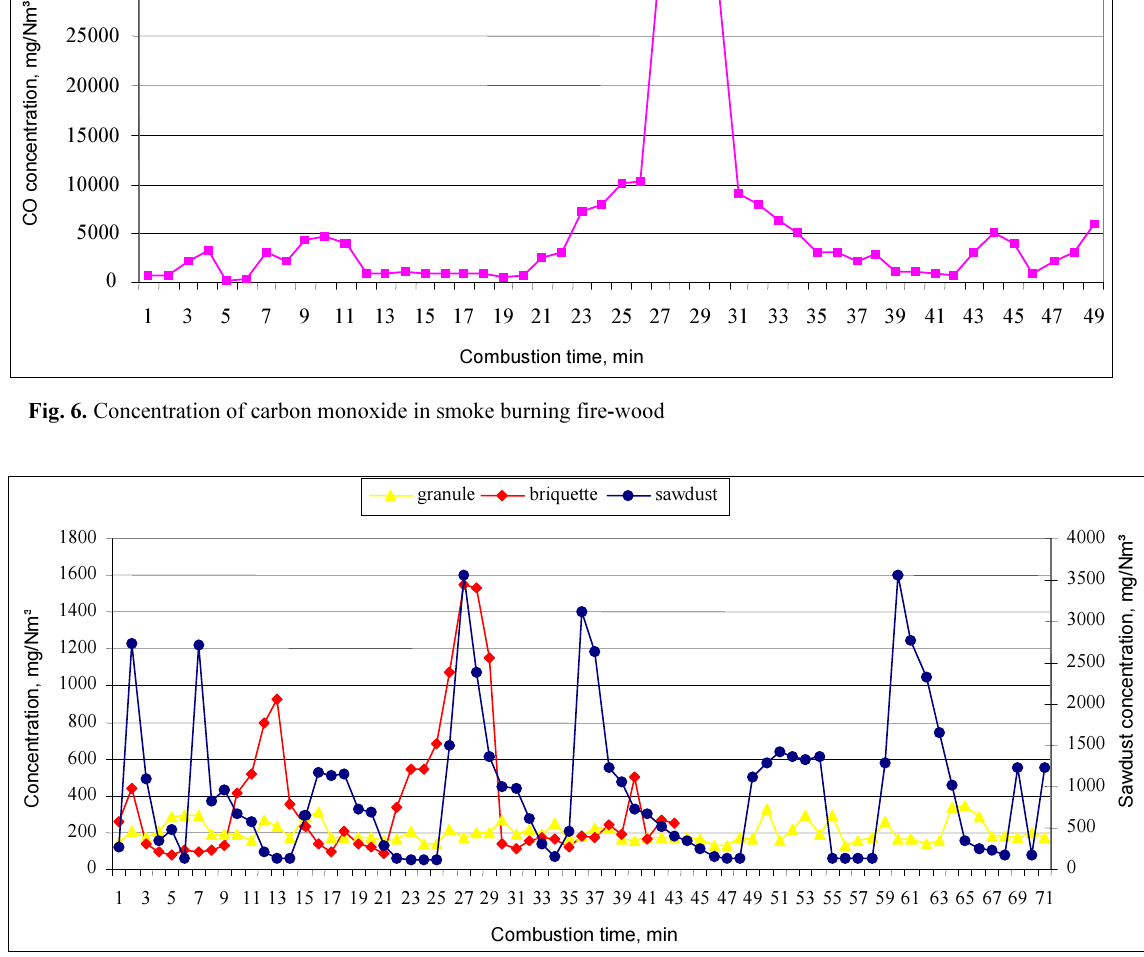
Fig. 7. Concentration of carbon monoxide in smoke burning granules, briquettes and sawdust